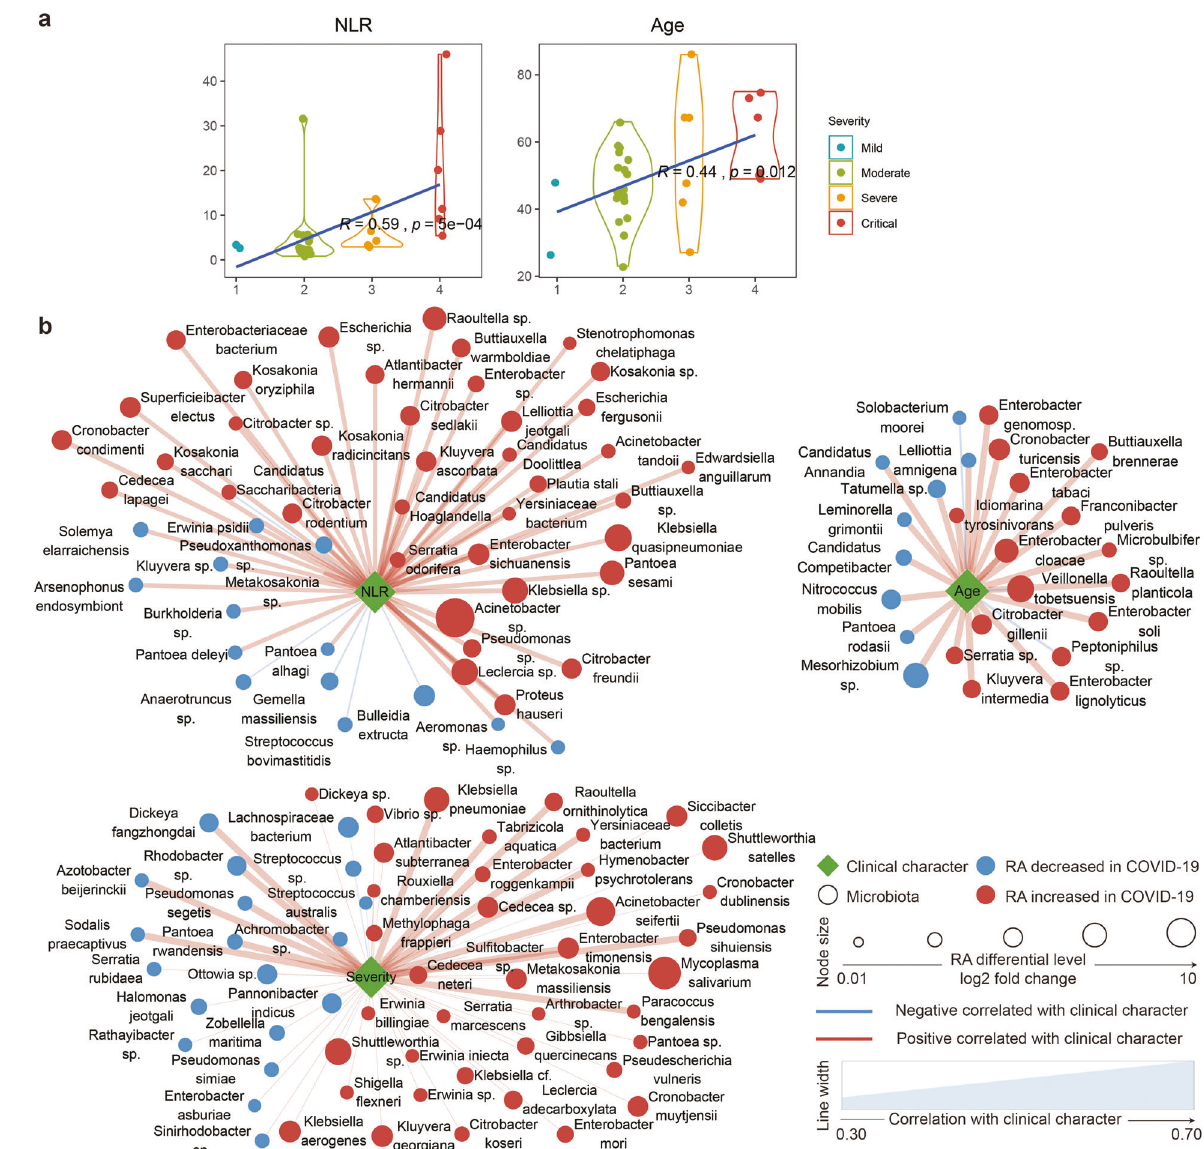
Fig. 3 Association between clinical characteristics and microbiota in COVID-19 patients. a Violin plot showing the correlation between clinical characteristics (neutrophil – lymphocyte ratio (NLR) and age) and the severity of COVID-19. Spearman correlation was used for correlation analysis. b Correlation networks between three clinical characteristics (COVID-19 severity, neutrophil – lymphocyte ratio (NLR), and age) and microbiota at the species level in COVID-19 patients. The nodes represent unique species, and the color of the nodes denotes an increase (red) or decrease (blue) in relative abundance when comparing COVID-19 patients with healthy controls. The size of the nodes shows the log2-fold- change values of the relative abundance in COVID-19 patients versus healthy controls. The edges denote the correlation between the species and the clinical characteristics, the color of the edge represents a positive (red) or negative (blue) correlation, and the width denotes the strength of the correlation metabolism was similar to that in the COVID-19 patients. Nucleotide metabolism (purine and pyrimidine), replication and repair (homologous recombination and mismatch repair) and folding, sorting and degradation (sulfur relay system and protein export) in the oropharyngeal microbiome of the COVID-19 or fl u patients were relatively depleted; however, the other functions in genetic information processing were neither enriched nor depleted. This fi nding suggests that the oropharyngeal micro- biome of the COVID-19 or fl u patients may have a lower genetic information processing ability. In particular, membrane transport (ABC transporters and the phosphotransferase system) and cell motility (bacterial chemotaxis and fl agellar assembly) were